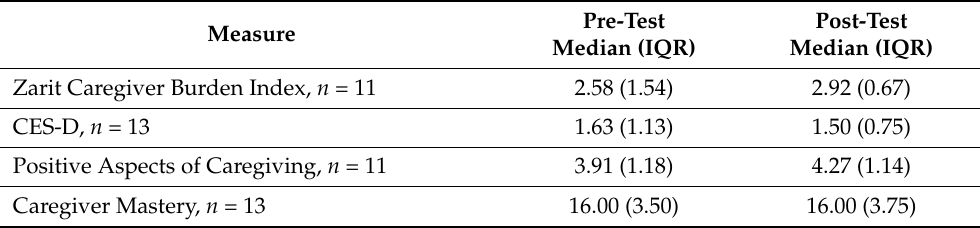
Table 2. Measures Assessed Before and After Savvy Caregiver Program (Unmatched sample). Pre-Test Measure Median (IQR)